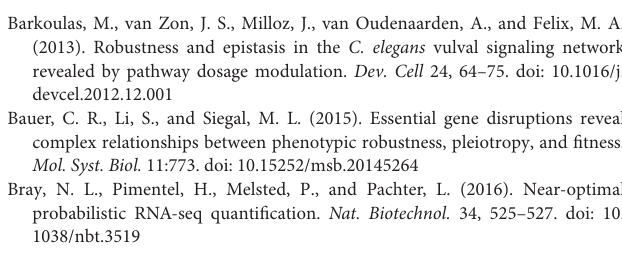
Supplementary Table 1 | List of strains used in this study. Supplementary Table 2 | List of plasmids, oligos and smFISH probes used in the study. Supplementary Table 3 | RNA-seq analysis and gene set